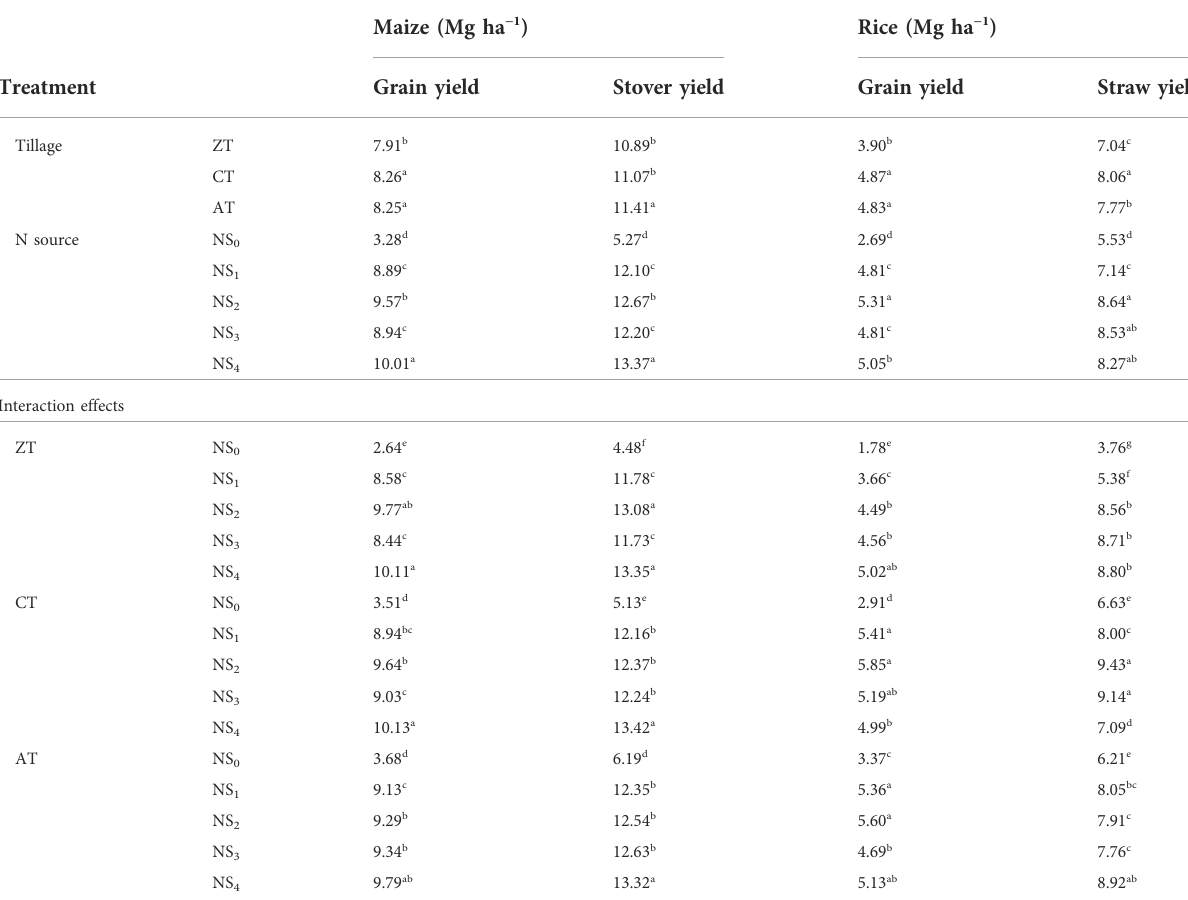
TABLE 2 Effects of tillage practices and N sources on the yield of maize and rice crop. Main and sub-plots